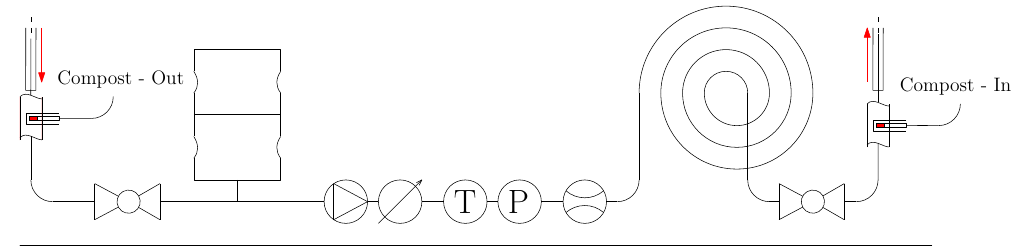
Figure 14. Design of the heat circuit.